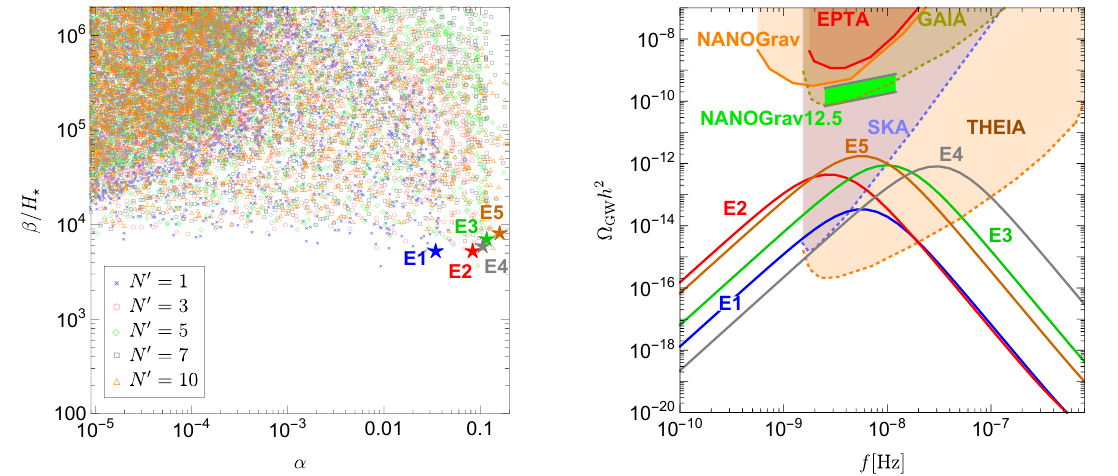
Figure 6 . Rethermalization scenario addressing the Hubble tension. Left panel: scatter plot in the ( α, β/H ) plane. Right panel: GW spectra for the five benchmark points E1–E5 in table 5 ? corresponding to N 0 = 1 , 3 , 5 , 7 , 10 , respectively, and marked with stars in the left panel.